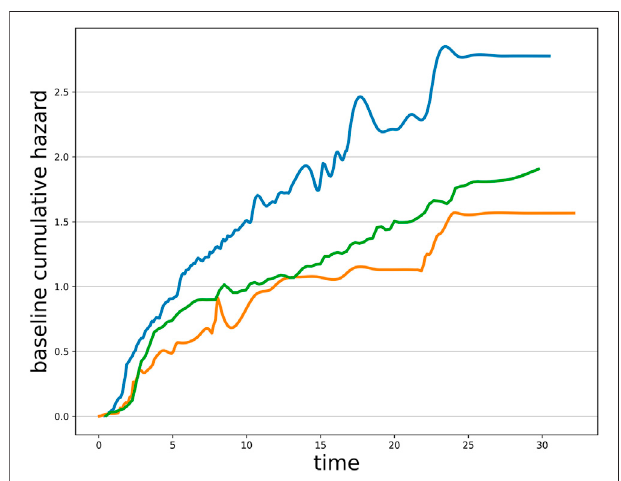
FIGURE 1 | The distribution of baseline cumulative hazard for patients receiving